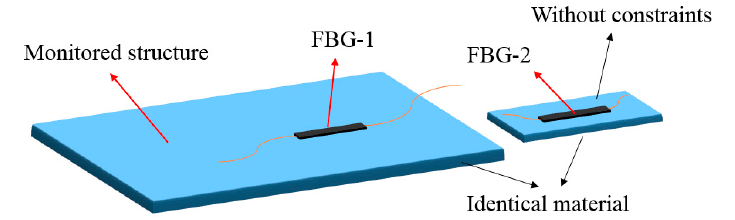
Figure 14. Configuration of the temperature compensation method.